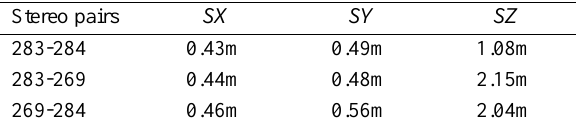
Table 5. 3D georeferencing accuracy by bias corrected RPC-